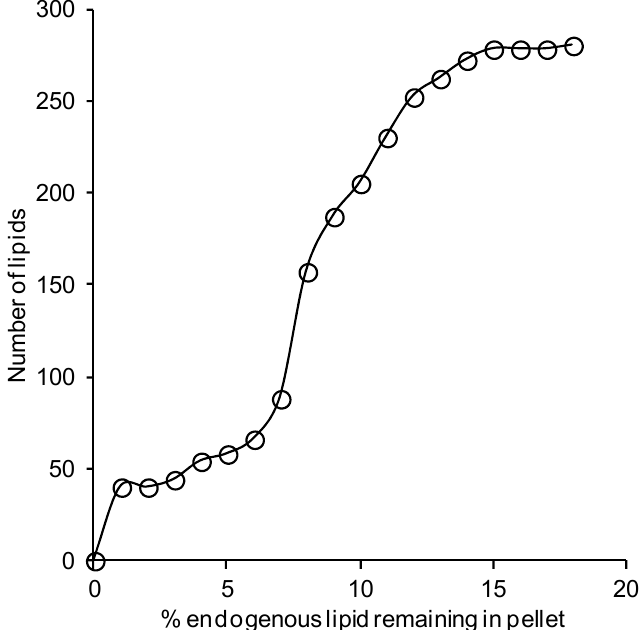
Figure 1. Recovery of lipids with the different extraction methods. The recovery calculated the percent of recovery of the method ( n = 5) against its spiked equivalent method ( n = 5). The black bars represent the recovery of chloroform/methanol against spiked chloroform/methanol, the gray bars represent the recovery of 1-butanol/methanol (3:1 v/v) against spiked 1-butanol/methanol (3:1 v/v) and the white bars represent the recovery of 1- butanol/methanol (1:1 v/v) against spiked 1-butanol/methanol (1:1 v/v).